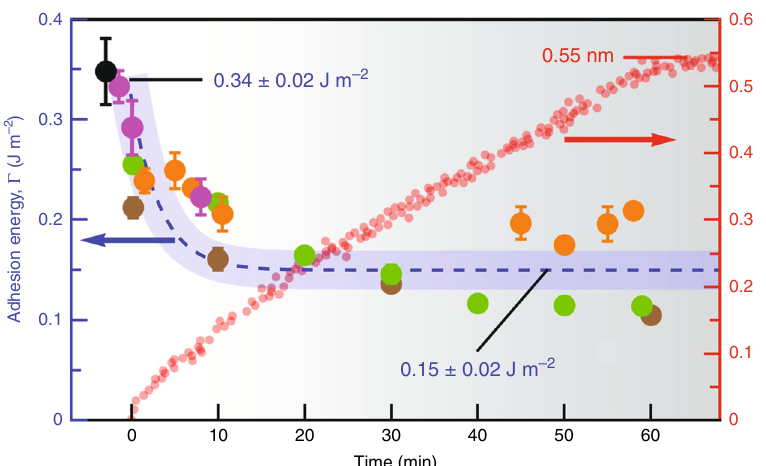
Fig. 5 Adhesion energy evolution in G crystal. Temporal evolution of the adhesion energy (left axis in blue) and contamination thickness (right axis in red) measured on the mechanically exfoliated HOPG surface during the fi rst 60 min of air exposure. Adhesion energy is extracted from WCA measurements of ref. 46 , ref. 47 , ref. 48 , ref. 49 , and ref. 24 denoted by black, brown, orange, magenta, and green circles, respectively. Adsorbed contamination layers linearly grow within the fi rst 60 min of air exposure, reaching a thickness of ~0.55 nm, and then the growth rate considerably decreases and plateaus at ~0.60 nm after several hours 24